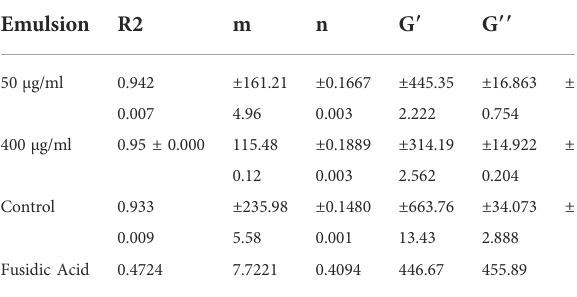
TABLE 3 Rheological parameters of O/W emulsions (60% wt. and HLB of 14) at two different concentrations of the MNPs-PEG8-BUF-II- Ag nanobioconjugate. The values of m and n were obtained from the power law. While G 9 and G 99 correspond to the mean values of each module and the corresponding standard